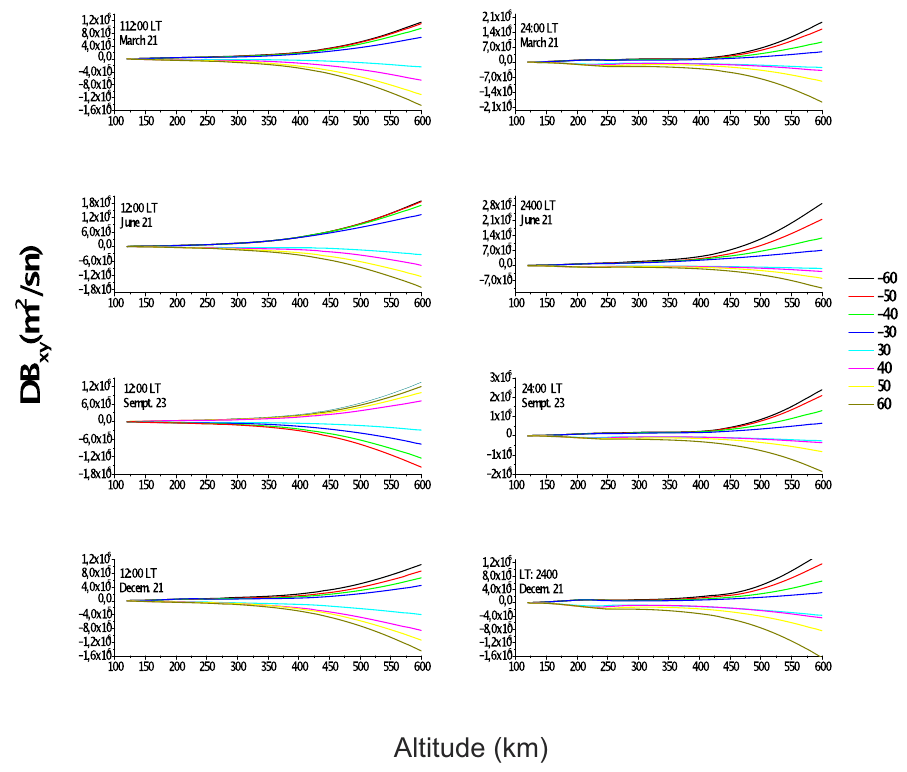
Altitude Figure 2. The seasonal diagram of diagonal elements in Equation (10) for mid-latitude in ionospheric plasma.